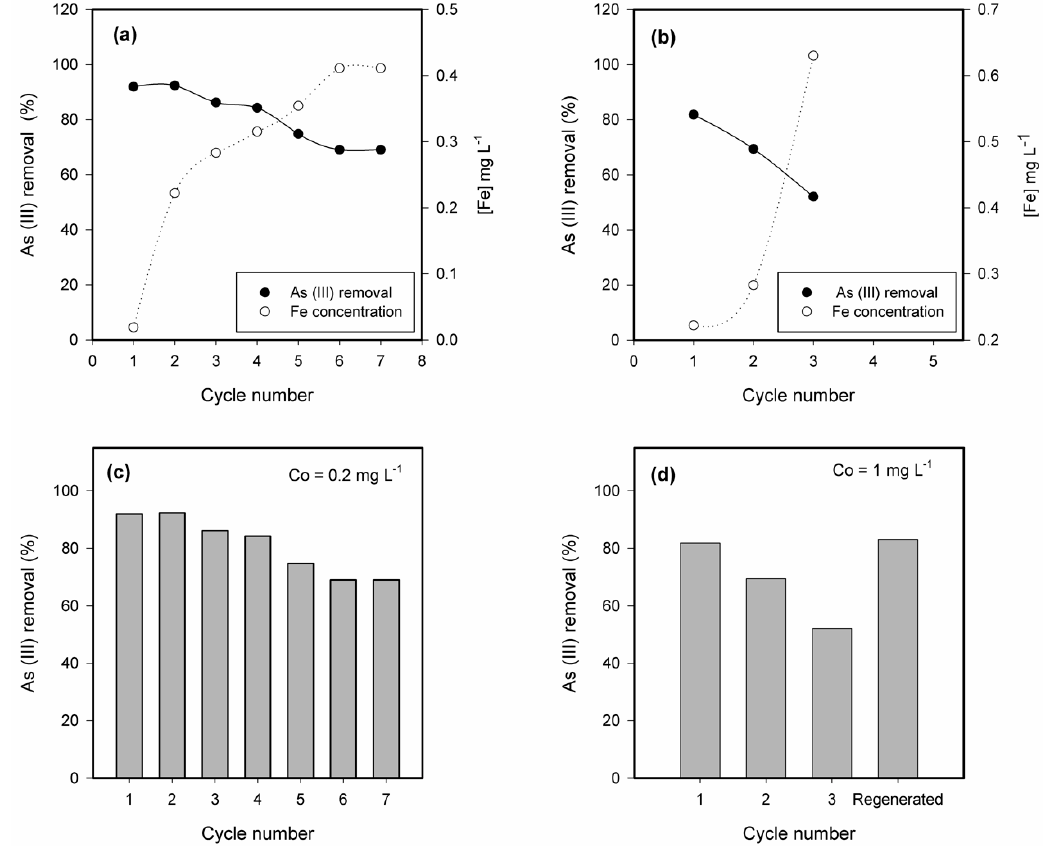
Figure 5. Arsenic removal and iron released at different concentrations ( a ) 0.2 mg L − 1 ; ( b ) 1 mg L − 1 ; ( c , d ) comparison of arsenic adsorption capacity of the pristine, reused and regenerated Fe-modified W zeolite .